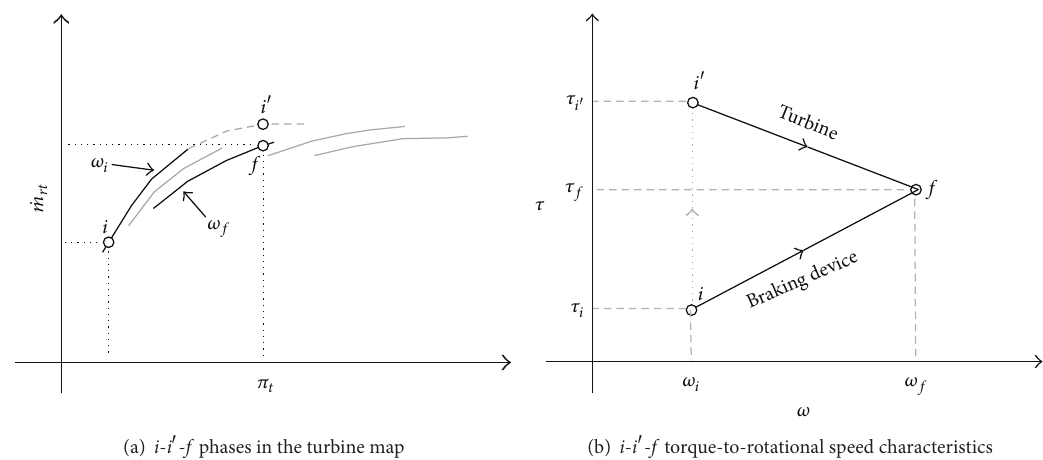
Figure 1: Decomposition of the transient phase from initial ( i ) to final ( f ) operating point through intermediate ( 𝑖 󸀠 ) operating